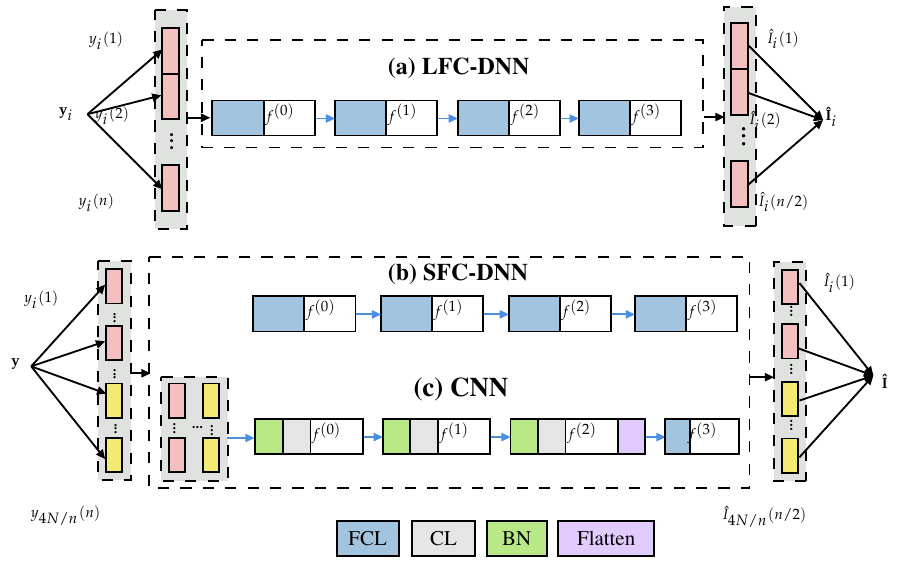
Figure 2. IE-DNN-assisted active LED IE structures for GLIM-MIMO system: ( a ) LFC-DNN, ( b ) SFC- DNN, ( c )